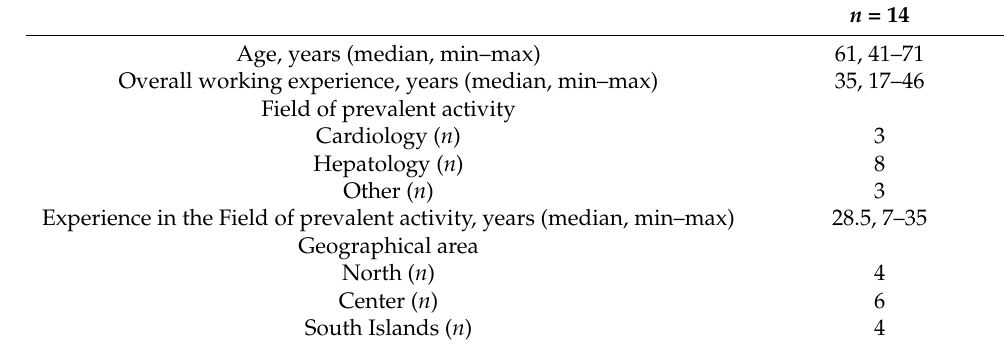
Table 1. Characteristics of the study